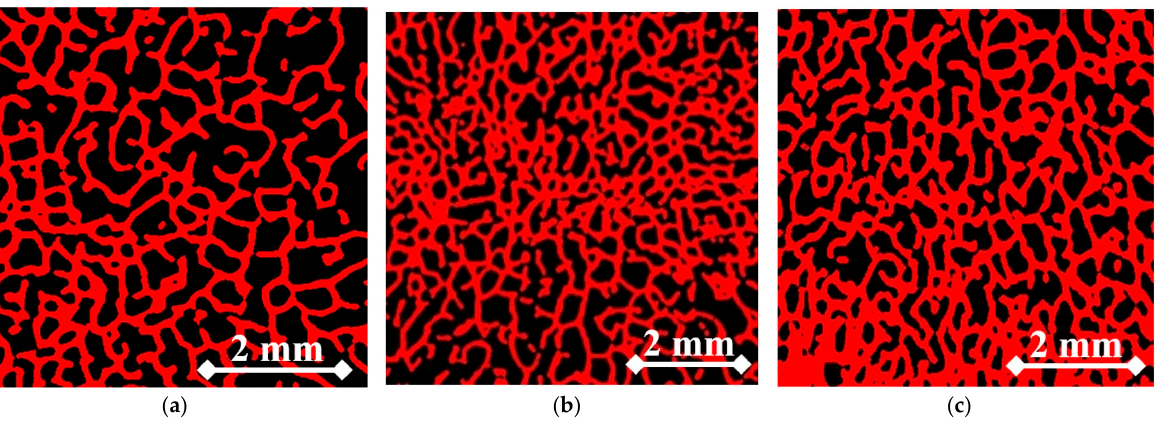
Table 3. Values of marrow and soft tissue fractions during embedding in the area of interest in the